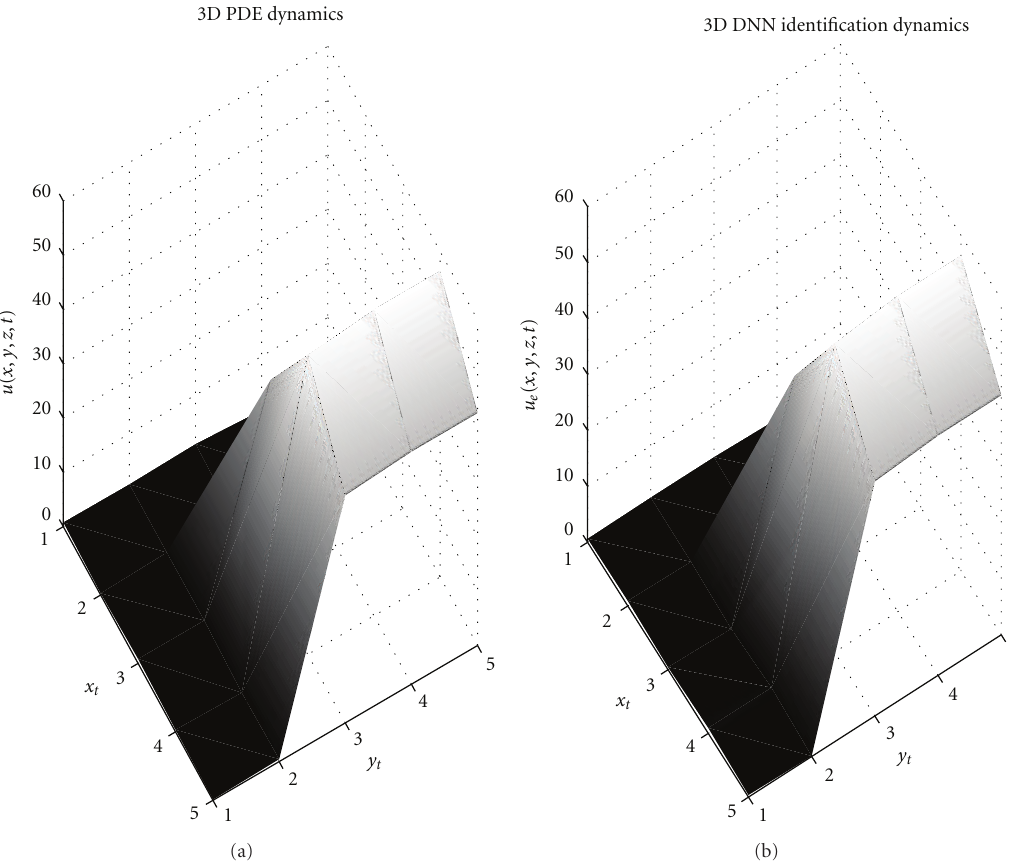
Figure 7: Numerical trajectory produced by the mathematical model described by 3D partial di ff erential equation at time 46 days along the whole